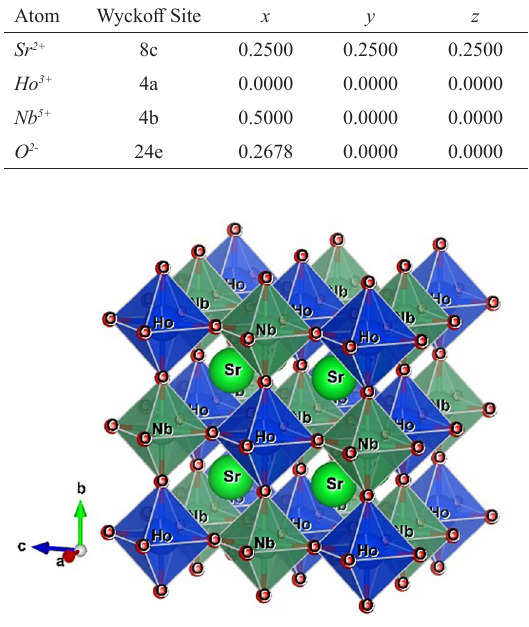
HoNbO cubic complex 2 6